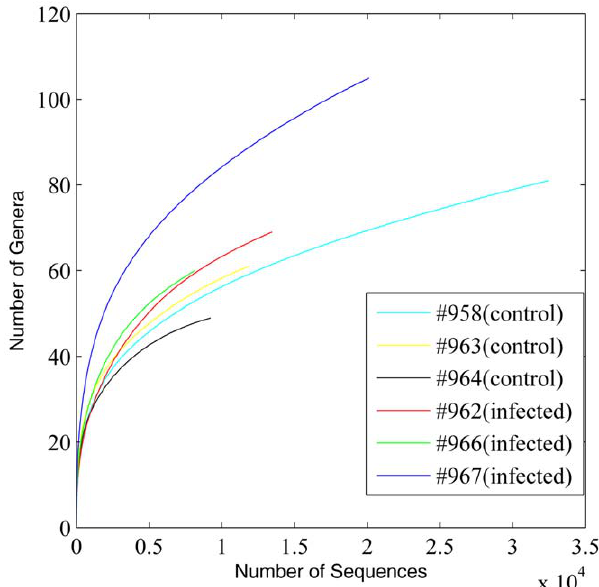
Figure 2. Genus-level rarefaction curves of control and infected animals based on the 16S rDNA sequences analyzed using RDP Classifier with a confidence threshold of 80%. doi:10.1371/journal.pone.0024417.g002 Lachnospiraceae (15.4%), Ruminococcaceae (11.1%), Succinivibrionaceae (7.1%), and Spirochaetaceae (4.3%). At the genus level, Prevotella was the most abundant, accounting for 63.1% and 46.4% of 16S rDNA sequences that were positively assigned in the microbiota of control and infected animals, respectively. Succinivibrio was ranked second in terms of its relative abundance, representing 10.9% and